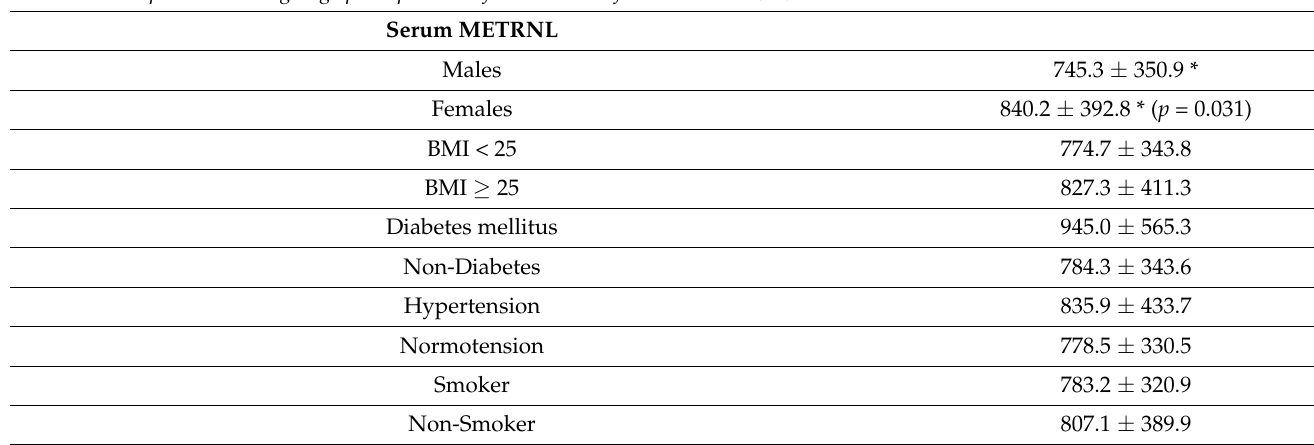
* consisting of dementia (8), psychiatric disorders (12), normal pressure hydrocephalus (8), and patients undergoing spinal puncture for exclusion of other diseases